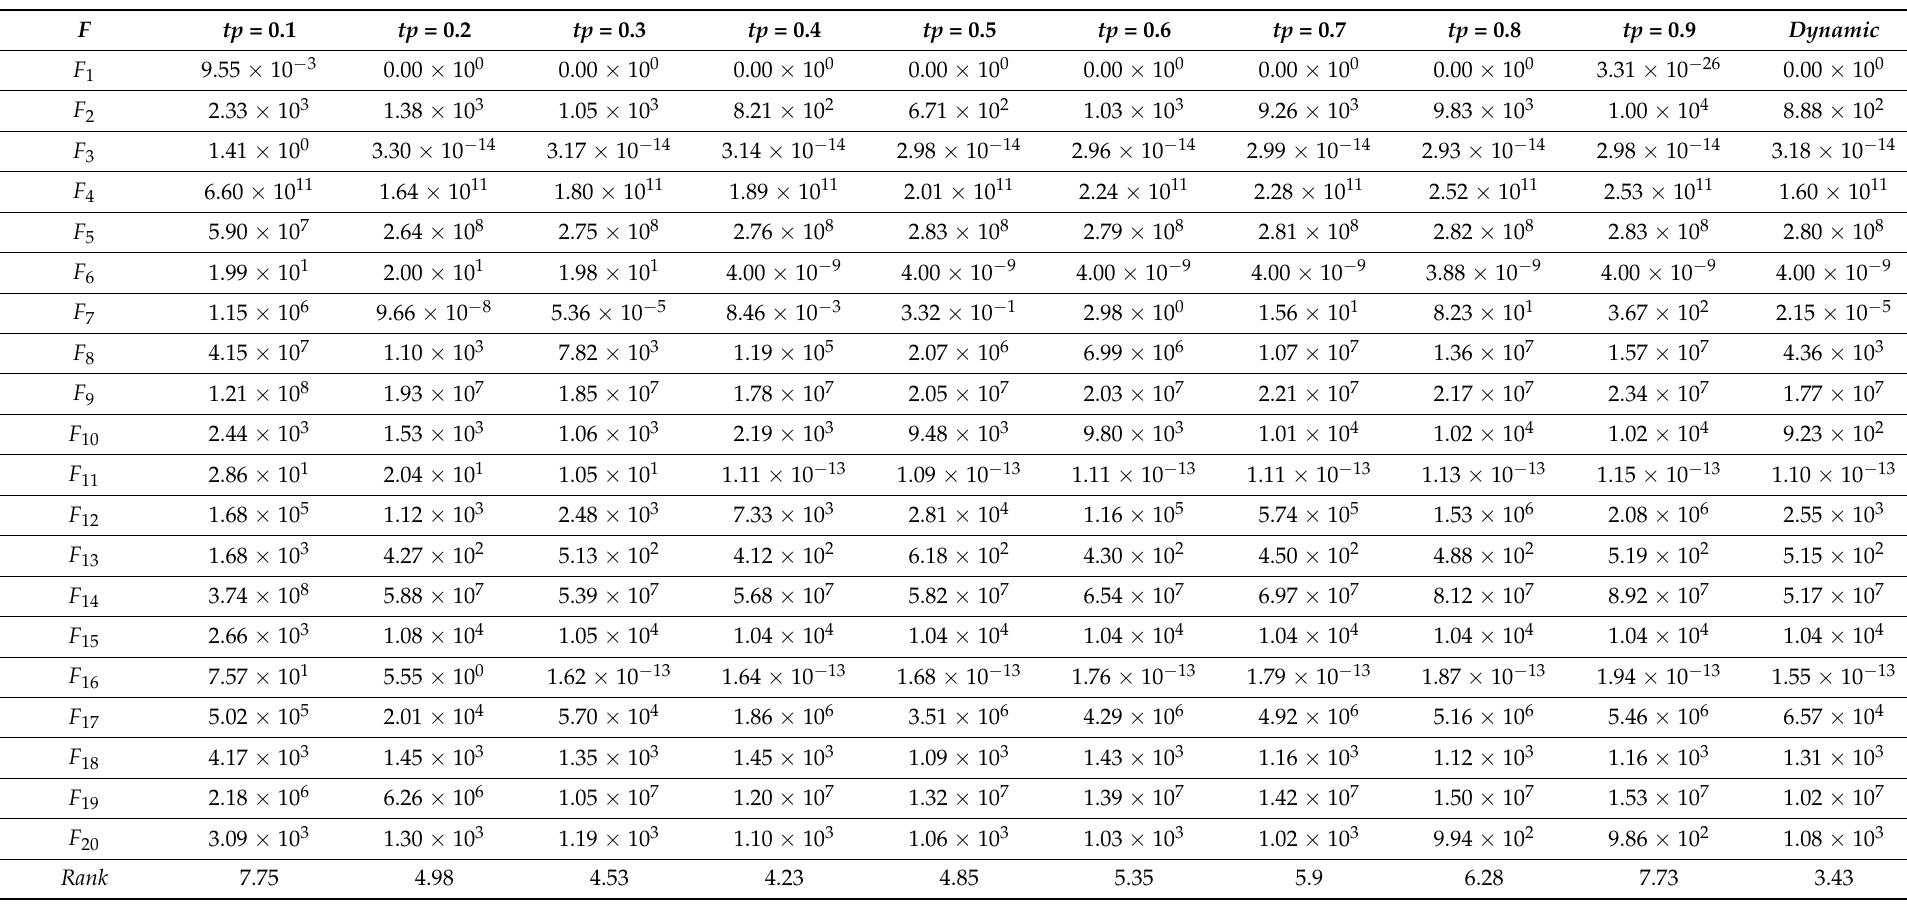
Table 6. Comparison results between DGCELSO with the dynamic strategy for tp and the ones with different fixed settings of tp on the 1000-D CEC’2010